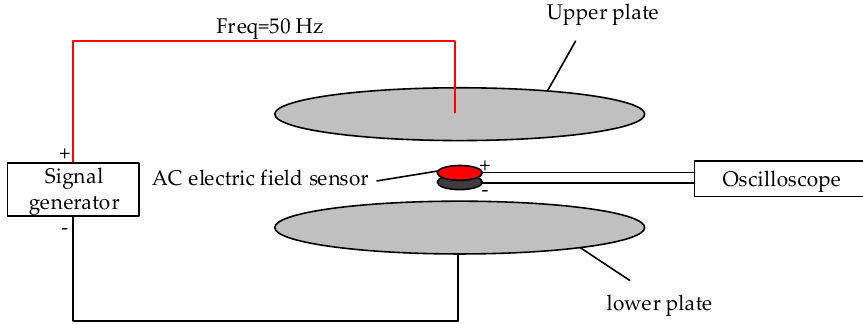
Figure 5. Block diagram of the experimental platform.